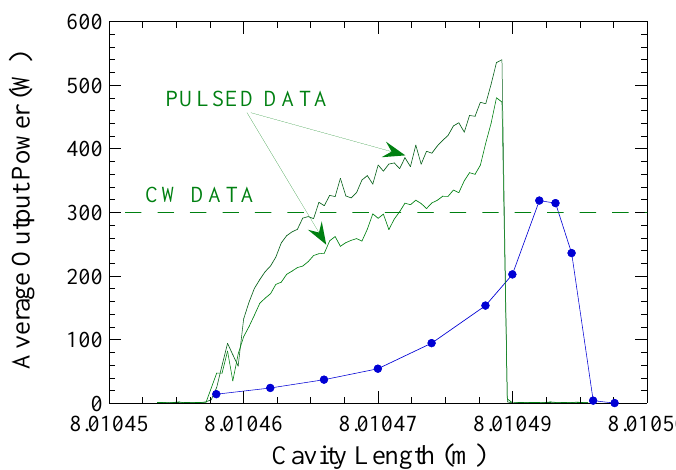
Figure 7. Tuning curve for the IR Demo experiment including measurements from CW and pulsed runs (green) and from simulation (blue). Other parameters as described in the